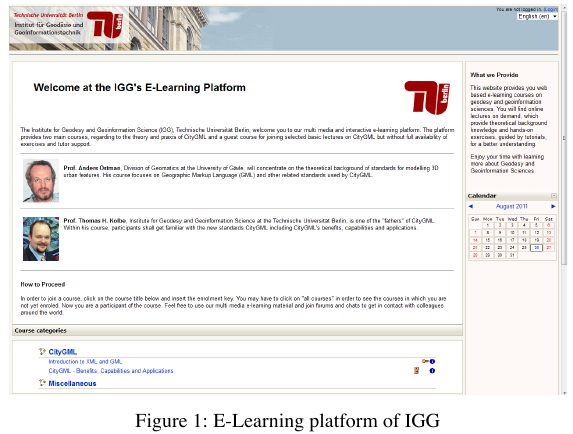
Figure 1: E-Learning platform of IGG http://www.igg.tu-berlin.de/courses